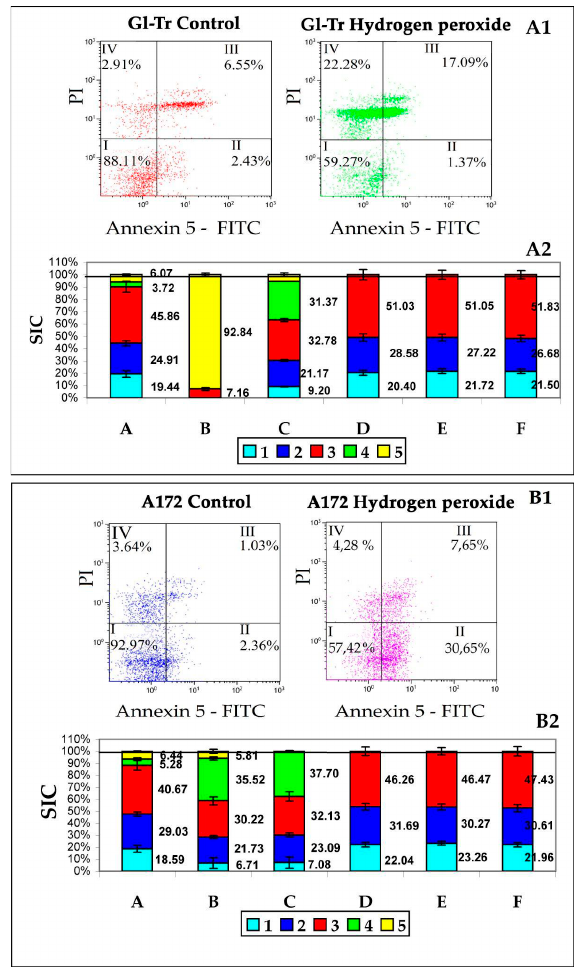
Figure 2. Assessment of the effect of hydrogen peroxide on cells and EPs production. Panel A1—results of the cytometric test for apoptosis of Gl-Tr line cells. I—living cells (Ann − /PI − ), II—early apoptosis (Ann + /PI − ), III—late apoptosis (Ann + /PI + ), IV— necrosis (Ann − /PI + ). Numbers are the proportion of cells from the total number of analyzed cells (20000). Panel B1—results of the cytometric test for apoptosis of A172 line cells. The designations are the same as on panel A1.